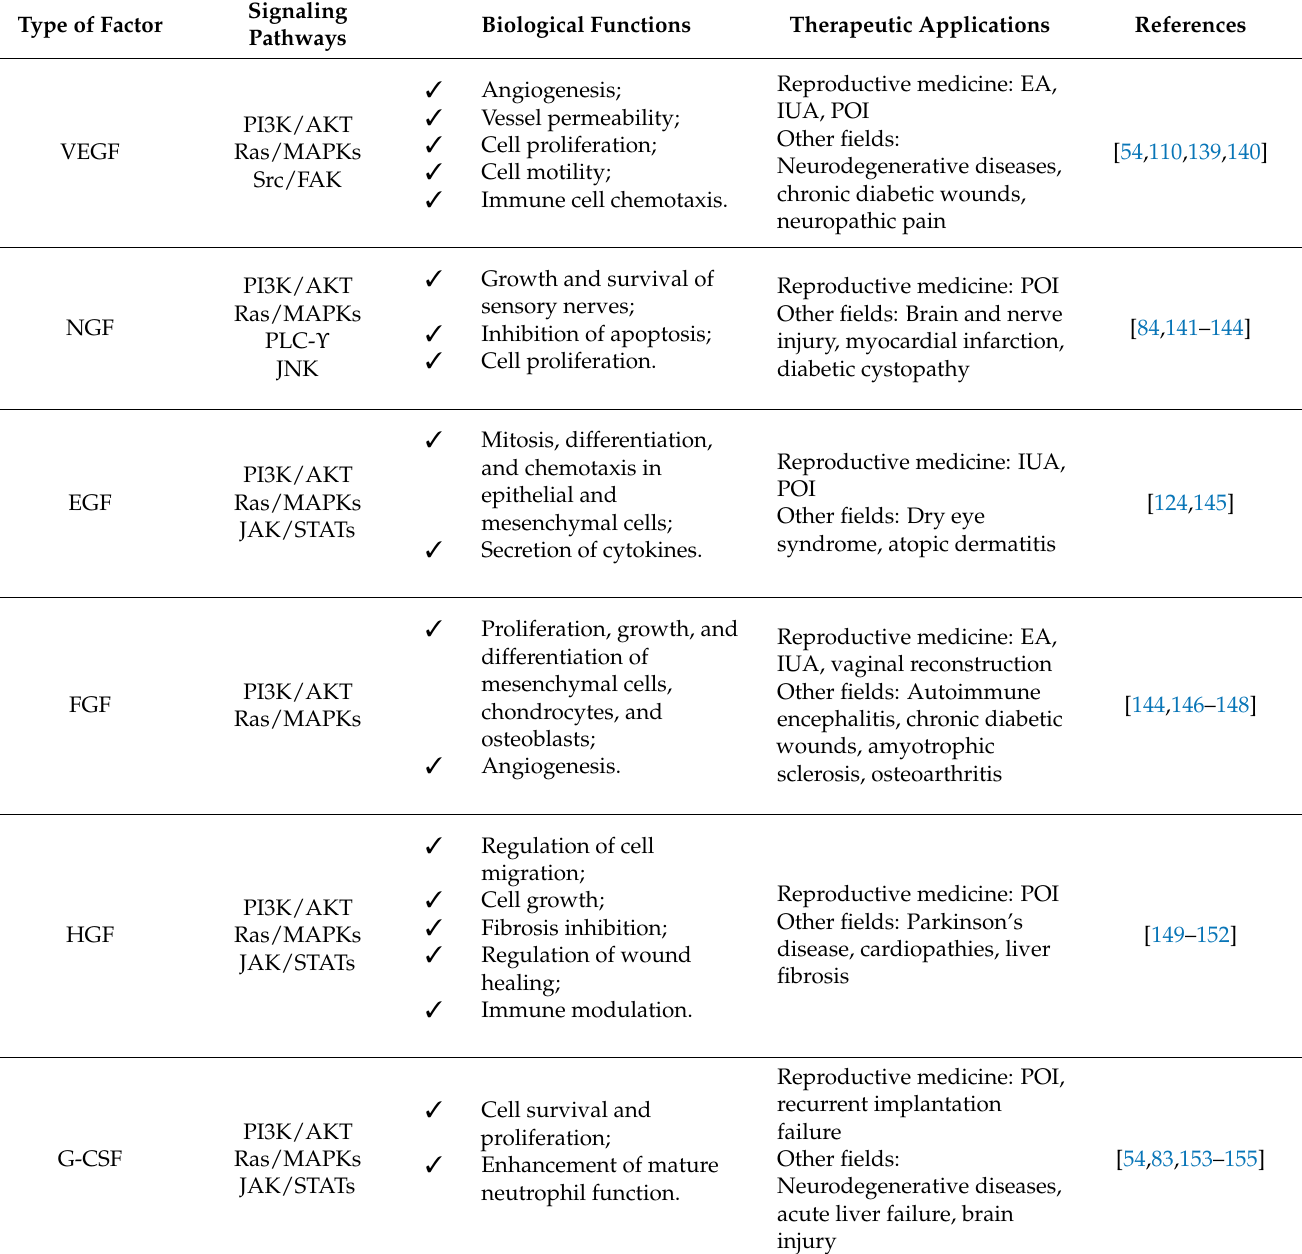
Table 1. Main growth factors secreted by hUC-MSCs and found in the acellular components of hUC blood. For each growth factor, this table lists the most prominent signaling pathways, biological functions, and therapeutic applications reported in the literature in reproductive medicine and other medical fields.